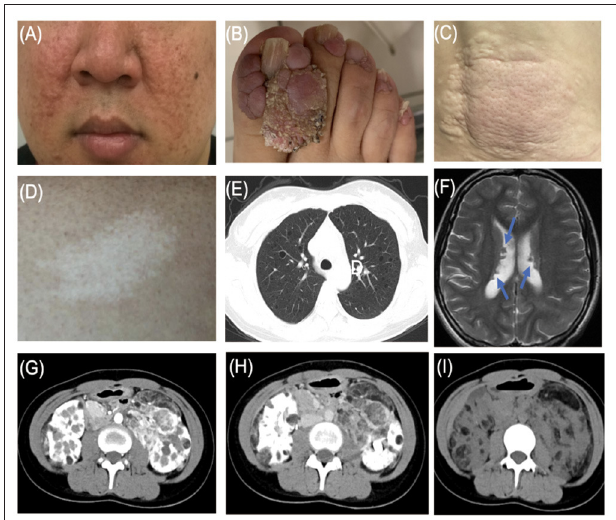
FIGURE 1 | Typical features of tuberous sclerosis complex (TSC). (A) Facial angiofibromas: small rashes usually found on the nose and cheeks (B) Ungual fibromas: fibrous around the finger or toenails. (C) Shagreen patch: thickened raised skin usually found on the lower back. (D) Hypomelanotic macules. (E) LAM: Lymphangioleiomyomatosis. (F) Subependymal nodule (arrow). (G) Angiomyolipoma (arterial phase). (H) Angiomyolipoma (venous phase). (I)